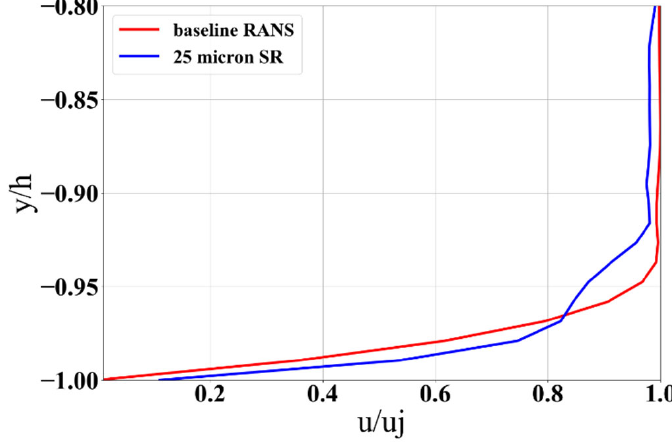
Figure 12. Effect of nozzle wall surface roughness on jet centerline velocity compared with PIV data from [60]. Figure 11. Boundary layer at nozzle exit with and without surface roughness. Figure 11. Boundary layer at nozzle exit with and without surface roughness.